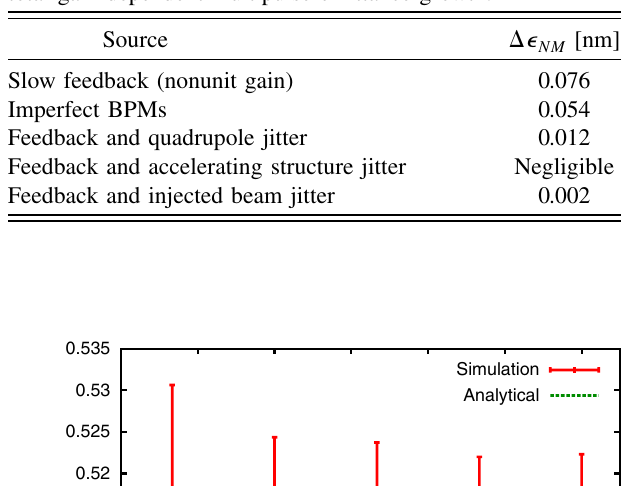
TABLE VI. Contributions of the different imperfections to the total gain-dependent multipulse emittance growth.